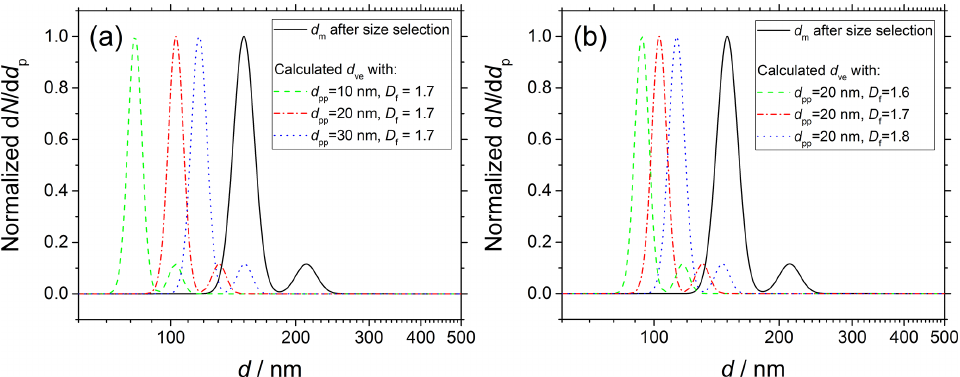
Figure 1. d m distribution of soot particles sampled from the kerosene jet diffusion flame at 130mm HAB and size selected at 150nm (solid black line) measured immediately before droplet nucleation experiments. Simulations of d ve = d ve (cid:0) d pp ,D f ,d m (cid:1) of soot particles having complex morphology according to Eq. (11). For each series of simulations (colored dashed and dotted lines), (a) d m and D f or alternatively (b) d m and d pp are set as constant, and the remaining parameter is varied in the range indicated in the